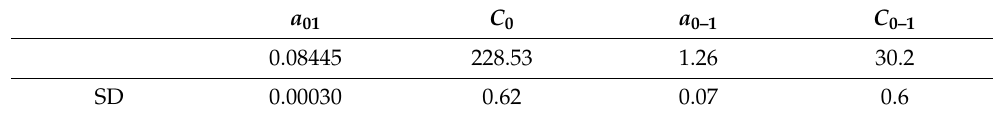
Table 4. The coefficients for Equation